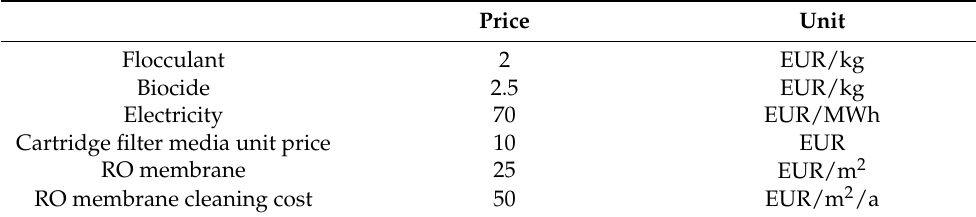
Table 1. Prices used for evaluating the variable